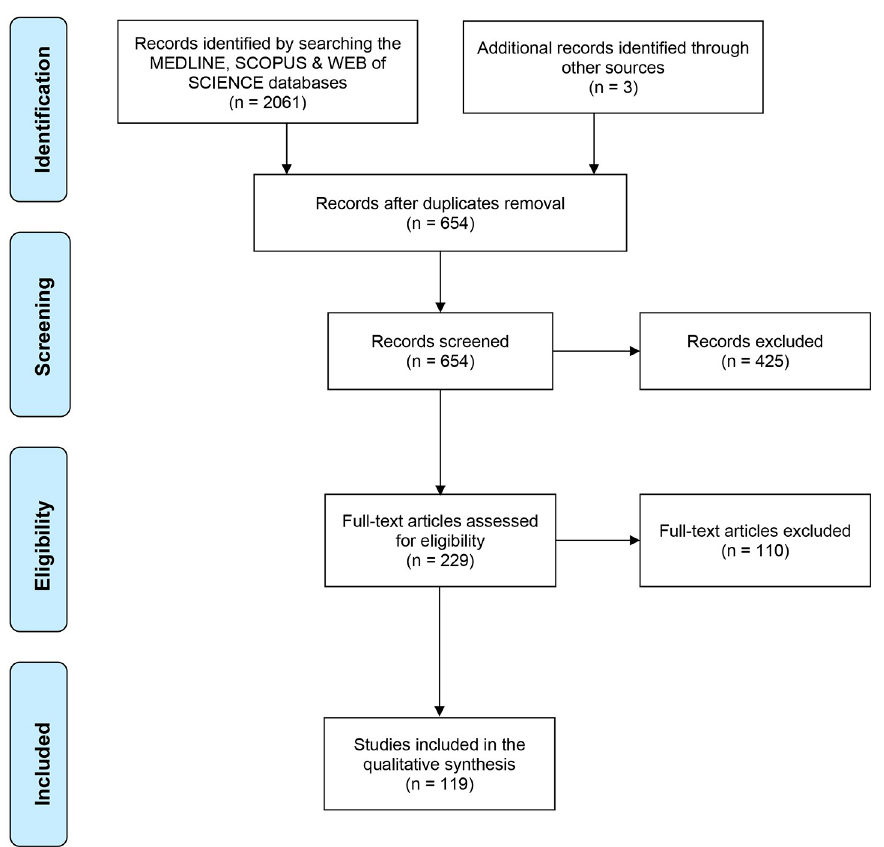
Fig 1. PRISMA Flow Diagram describing the screening process for the systematic